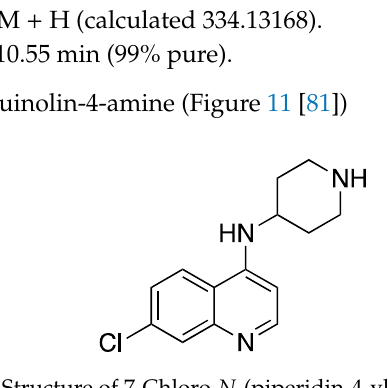
solid was also isolated from the aqueous layer by vacuum filtration (1.04 g). NMR indicated that both solids obtained were the desired product (total yield 1.83 g, 96%, mp = 166.3–169.4 °C). 1 H NMR δ (ppm)(CDCl 3 ): 8.52 (1 H, d, J = 5.39 Hz), 7.96 (1 H, d, J = 2.18 Hz), 7.65 (1 H, d, J = 8.96 Hz), 7.37 (1 H, dd, J = 8.93, 2.19 Hz), 6.45 (1 H, d, J = 5.42 Hz), 4.87 (1 H, br d, J = 7.35 Hz), 3.61–3.62 (1 H, m), 3.19 (2 H, dt, J = 12.68, 3.70 Hz), 2.79–2.81 (2 H, m), 2.15–2.19 (2 H, m), 1.50–1.50 (2 H, m). MS (ESI): m/z 262.11116 M + H (calculated 262.11065).